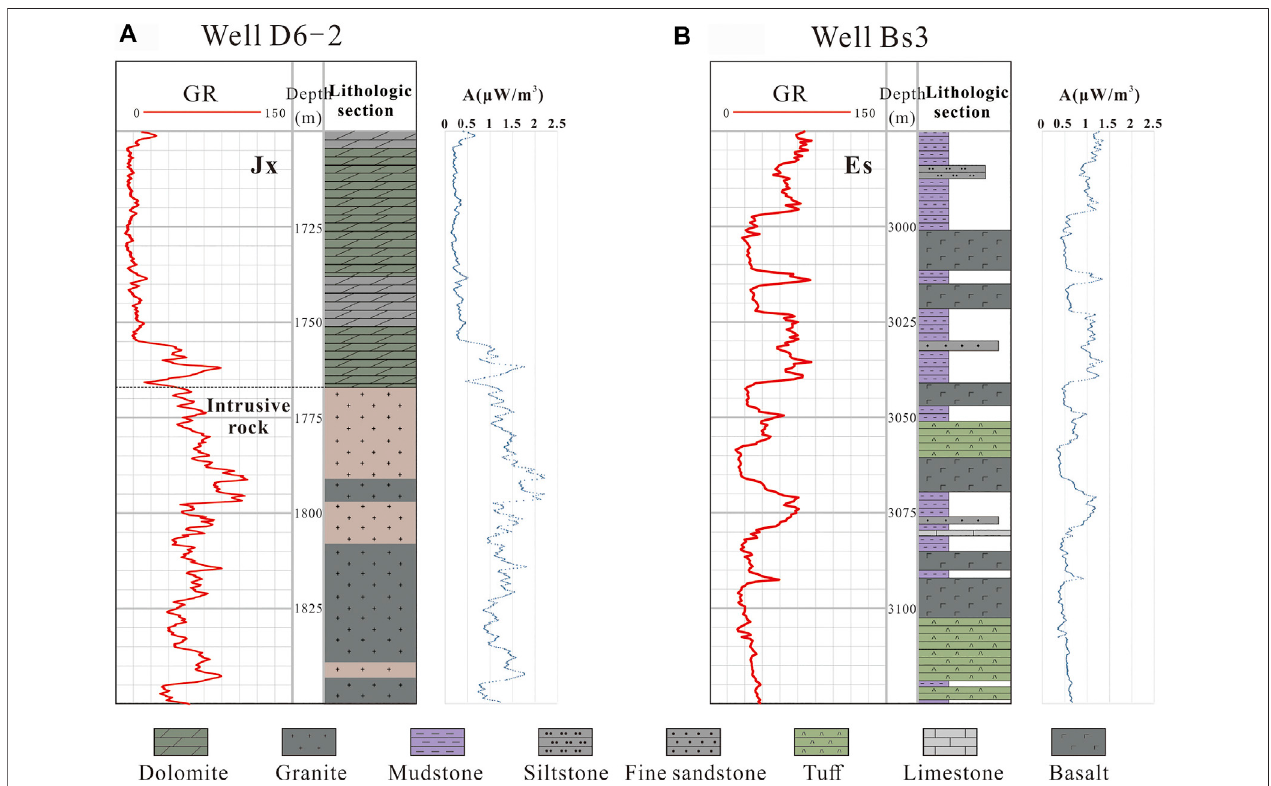
FIGURE 4 | The curves of GR logging and calculated heat production rate of (A) Wells D6-2 and (B) Well Bs3.